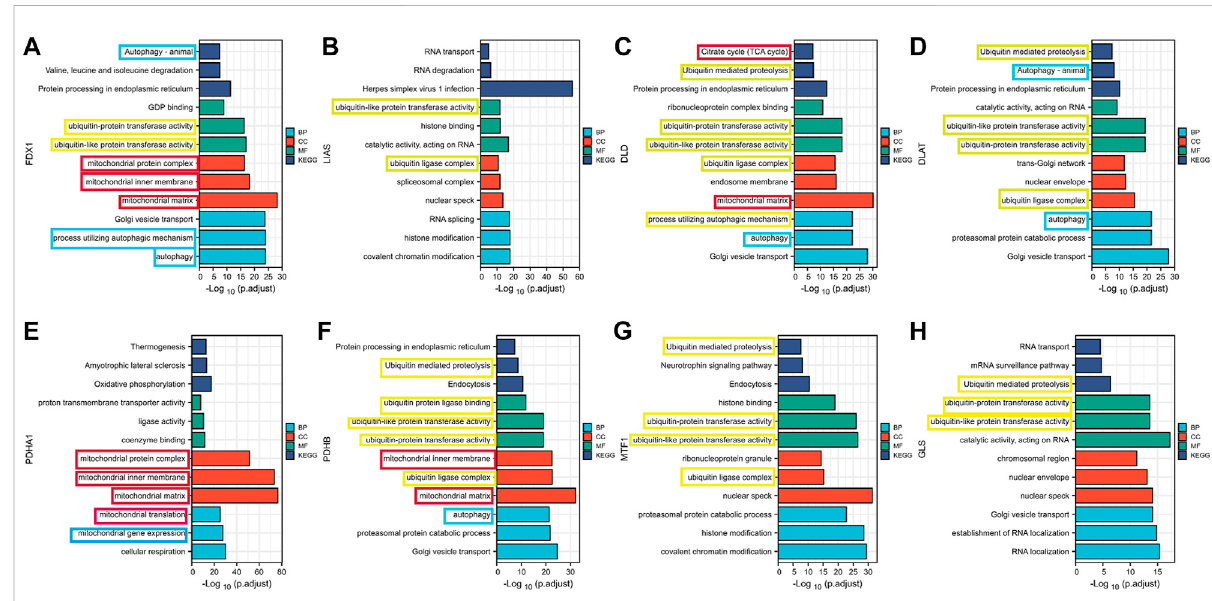
FIGURE 2 ResultsofGOandKEGGenrichmentanalysisofcuproptosisco-expressiongenes (A) FDX1; (B) LIAS (C) DLD; (D) DLAT; (E) PDHA1; (F) PDHB; (G) MTF1; (H)